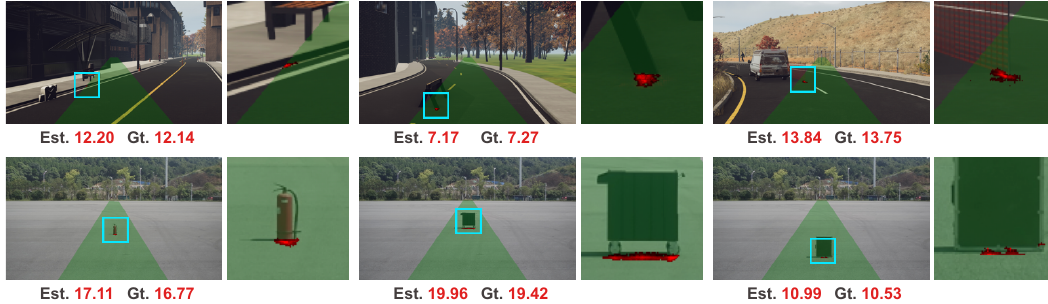
Figure 7. Results on objects of various